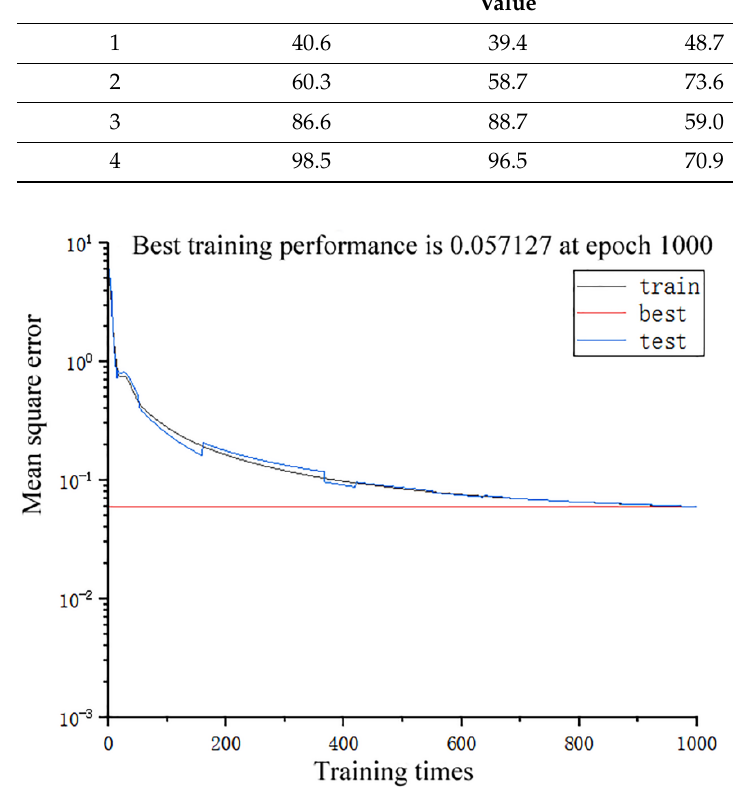
Figure 7. Relationship between mean square error and training times. Table 5. The model and simulation values of delay in inside and outside left-turn lanes.